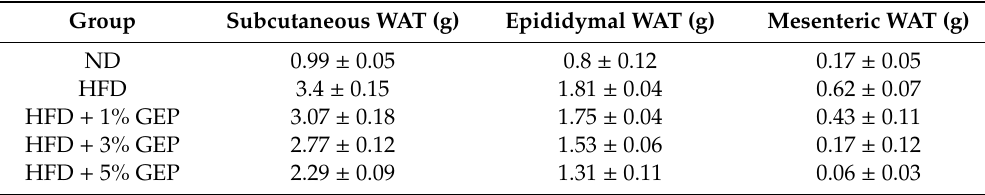
Table 4. White adipose tissue (WAT) weight in HFD-induced obese mice treated with GEP. Group Subcutaneous WAT (g) Epididymal WAT (g)